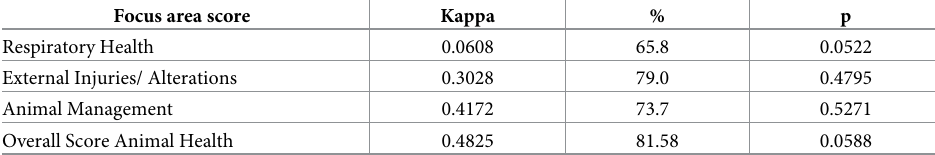
Table 6. Kappa coefficients for a dichotomous division (% = concordance; p = p-value for the McNemar test of similarity).